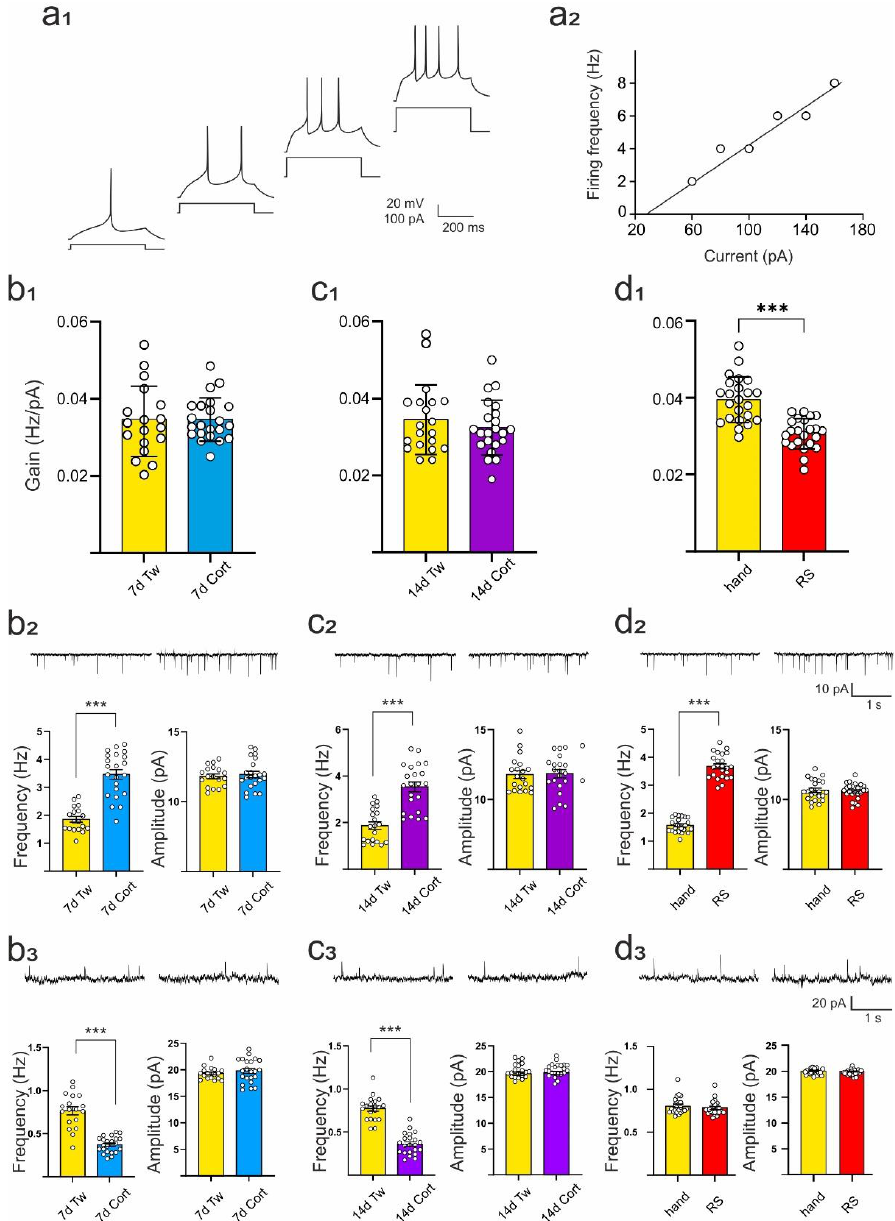
Figure 2. The effects of repeated corticosterone administration lasting 7 or 14 days and restraint stress on the excitability and spontaneous postsynaptic currents recorded from DRN neurons. ( a 1 ) Response of a representative putative 5-HT cell to depolarizing current pulses of increasing intensity; ( a 2 ) Rela- tionship between spiking rate and injected current for the cell shown in ( a 1 ). The slope of the straight line fitted to experimental data represents gain; ( b 1 , c 1 , d 1 ) Graphs showing the effects of repeated corticosterone administration lasting 7 days (7d Cort) or 14 days (14d Cort) and restraint stress (RS) on the gain of DRN neurons; ( b 2 , c 2 , d 2 ) The effects of repeated corticosterone administration lasting 7 days or 14 days and restraint stress on the mean frequency ( left ) and mean amplitude ( right ) of sESPCs. Shown in the upper part of each panel are sample sEPSC recordings from representative neurons from each group; ( b 3 , c 3 , d 3 ) The effects of repeated corticosterone administration lasting 7 days or 14 days and restraint stress on the mean frequency ( left ) and mean amplitude ( right ) of sIS- PCs. Shown in the upper part of each panel shown are sample sIPSC recordings from representative neurons of each group. Bars represent mean values ± SEM, with circles representing individual cells. 7d Tw, 14d Tw—vehicle administered for 7 and 14 days, respectively; a hand—handling. *** p <